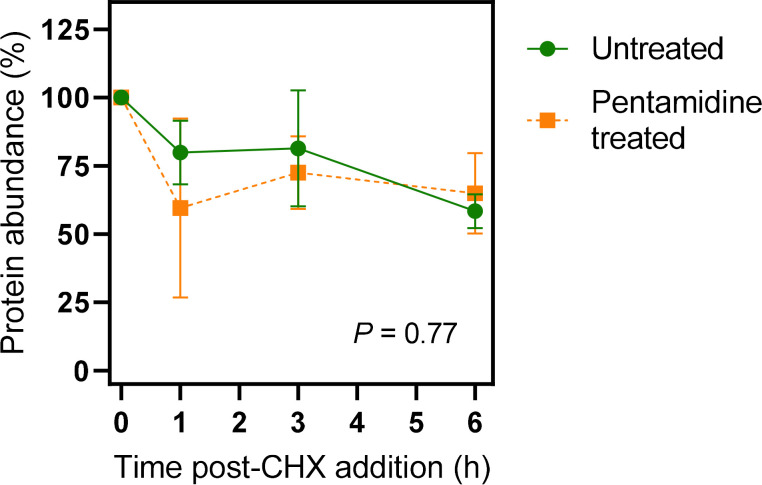
Quantification of western blots of 3×HATbAQP2.Cells were induced for expression of 3×HATbAQP2, pretreated with cyclohexidine and subsequently with 25 nM pentamidine (5× EC50). Western blots (Figure 6—figure supplement 1) were performed using anti-HA antiserum in order to quantify the relative amount of TbAQP2 in the cells. The two datasets were not significantly different by Kolmogorov-Smirnov test (p=0.77) and data points at each time point were also not significantly different by Student’s t-test (p>0.05). All data for these graphs are contained in Figure 6—source data 1.Figure 6—source data 1.Densitometry readings with Western blotting of TbAQP2 turnover, normalised to 0 h.